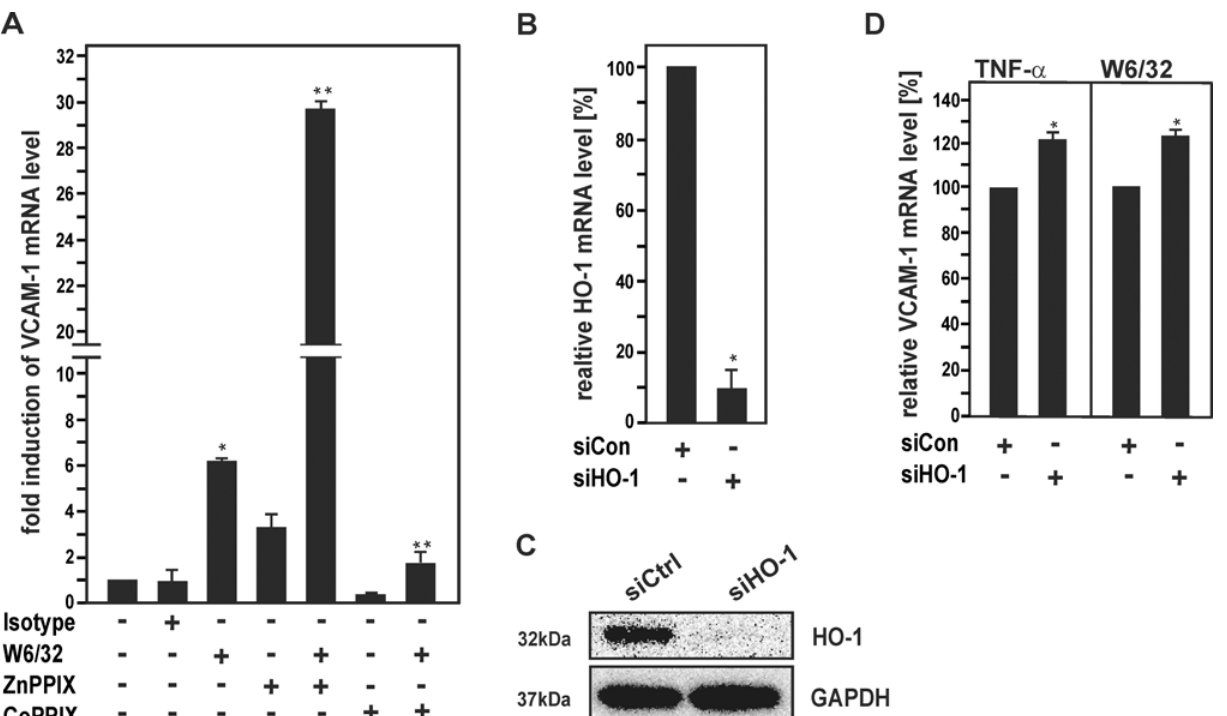
Fig 3. Pharmacological inhibition and siRNA-mediated knockdown of HO-1 reduce HLA I Ab-induced VCAM-1 expression in HUVECs. (A) HUVECs were incubated with HLA I Ab W6/32 alone (10 μ g/ml) and for 18 h in the presence of CoPPIX (5 μ M) or ZnPPIX (5 μ M), as indicated. Cells were lysed and subjected to RT-PCR analysis. The fold induction of VCAM-1 mRNA levels is shown. (B-D) HUVECs were transfected with siRNA for HO-1 or scrambled control siRNA. (B) mRNA expression was determined by RT-PCR analysis and relative levels of HO-1 mRNA are shown. (C) Protein expression was determined by Western blot analysis and probed sequentially with Abs against HO-1 and GAPDH. A representative of three independent experiments is shown. (D) Transfected HUVECs were treated with TNF α (15 ng/ml) or W6/32 for 18 h. Cells were lysed and subjected to RT-PCR analysis. The fold induction of mRNA levels is indicated. Bar graphs represent mean ± SEM from three independent experiments. * p (cid:3) 0.05, significant differences treatment versus control; ** p (cid:3) 0.05, W6/32 versus W6/32 plus CoPPIX/ ZnPPIX. Con, control.